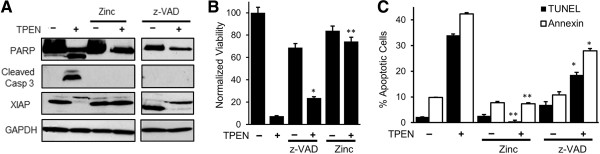
TPEN-dependent cell death is partially due to apoptosis induction. A) Cleavage of PARP, caspase-3 and degradation of XIAP in TPEN-treated cells was reversed by the addition of z-VAD-fmk or ZnSO4. B) MTT viability assay in control (-) and TPEN-treated (+) cell in the presence of either z-VAD-fmk to inhibit caspases or ZnSO4 (mean ± SD, n = 3). C) Annexin and TUNEL assays under similar condition as in panel A) (mean ± SD, n = 3). *p < 0.05 and ** p < 0.01, significant difference with respect to TPEN.